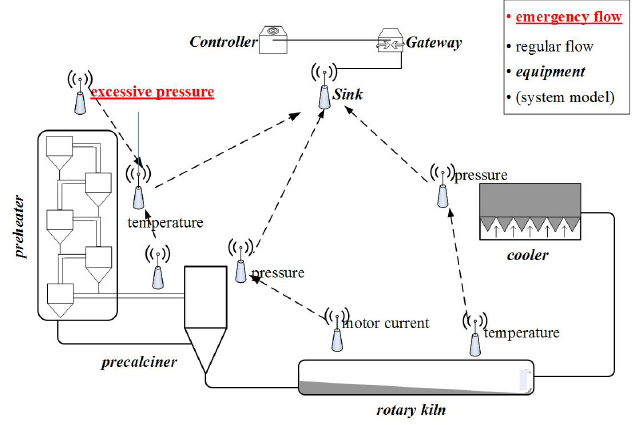
Figure 1. An example of an